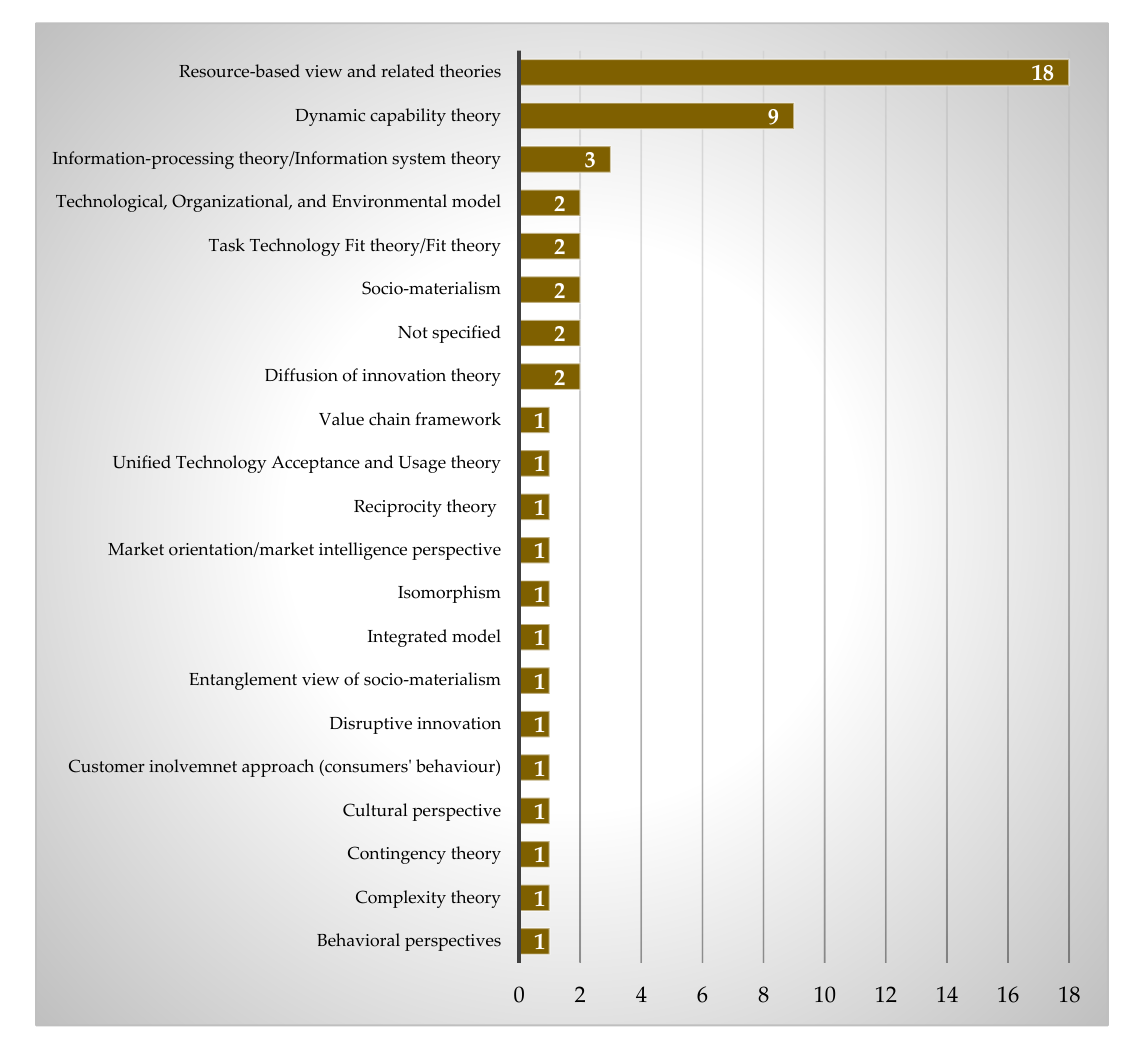
Figure 4 . The frequency of theories cited . Figure 4. The frequency of theories